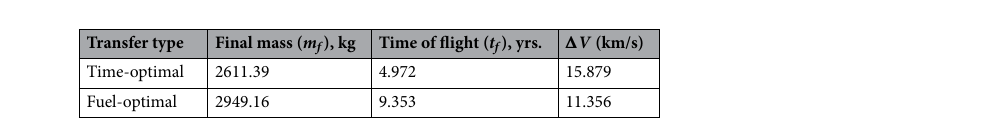
Table 1. Nominal trajectory parameters, time- and